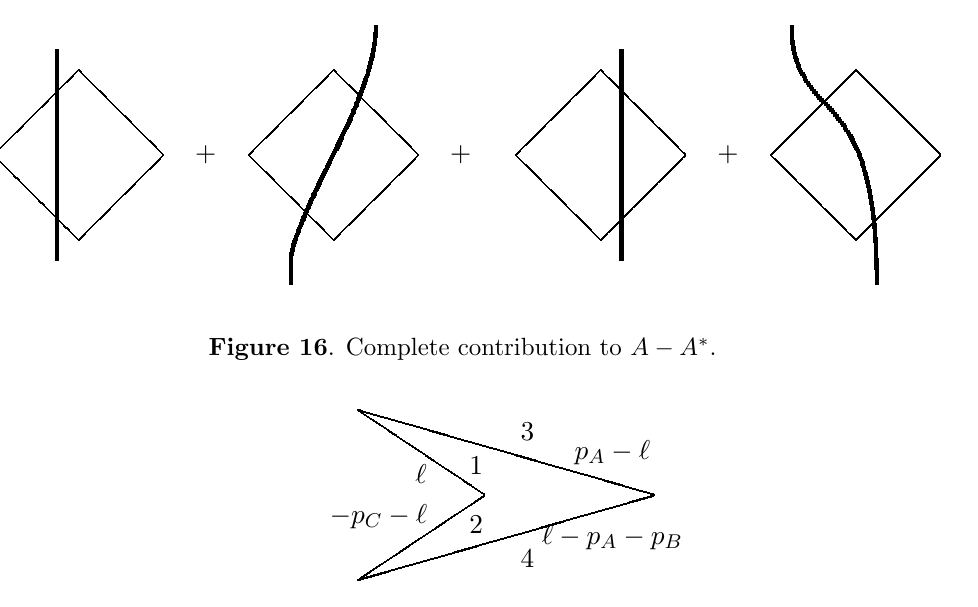
Figure 17 . A reduced diagram in which non-adjacent propagators 1 and 4 have poles on the same side at the pinch. At the pinch the energy (cid:13)ows from left to right in each of the propagators. In the (cid:12)gure the momenta are labelled so that they (cid:13)ow from left to